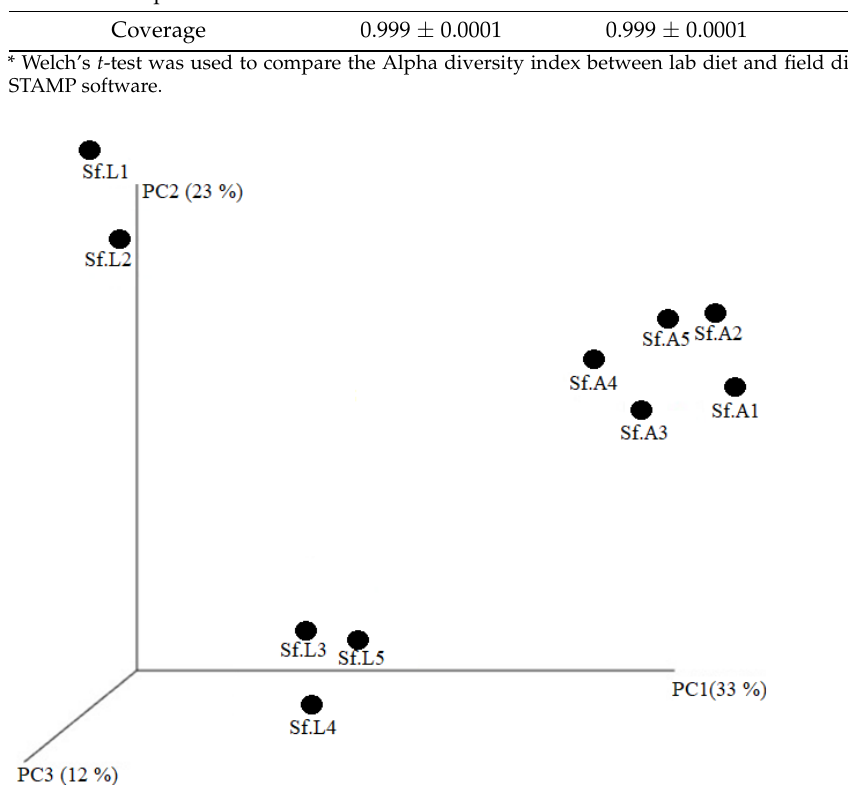
Figure 1. Beta diversity analysis: The PCoA showed the unweighted Unifac distance. Datasets were subsampled to equal depth before the UniFrac distance computation. S. frugiperda population feeding on corn leaf (Sf.L1,2,3,4,5); S. frugiperda population feeding on starch-rich artificial diet (Sf.A1, 2,3,4,5). Table 1. Comparison of α‐ diversity indices of gut microbiota from the “lab diet” and “field diet” groups *.